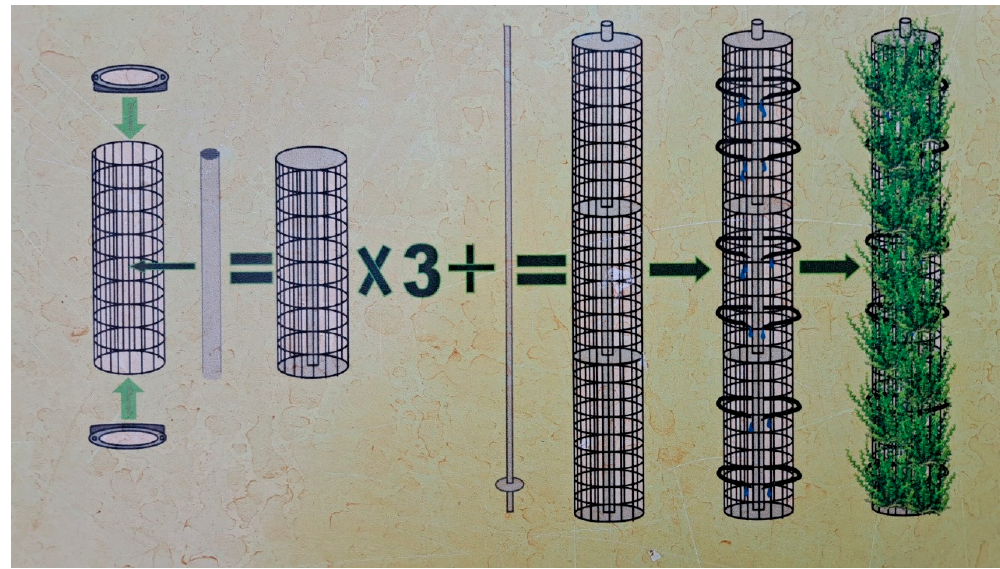
Figure 7. The vertical column construction